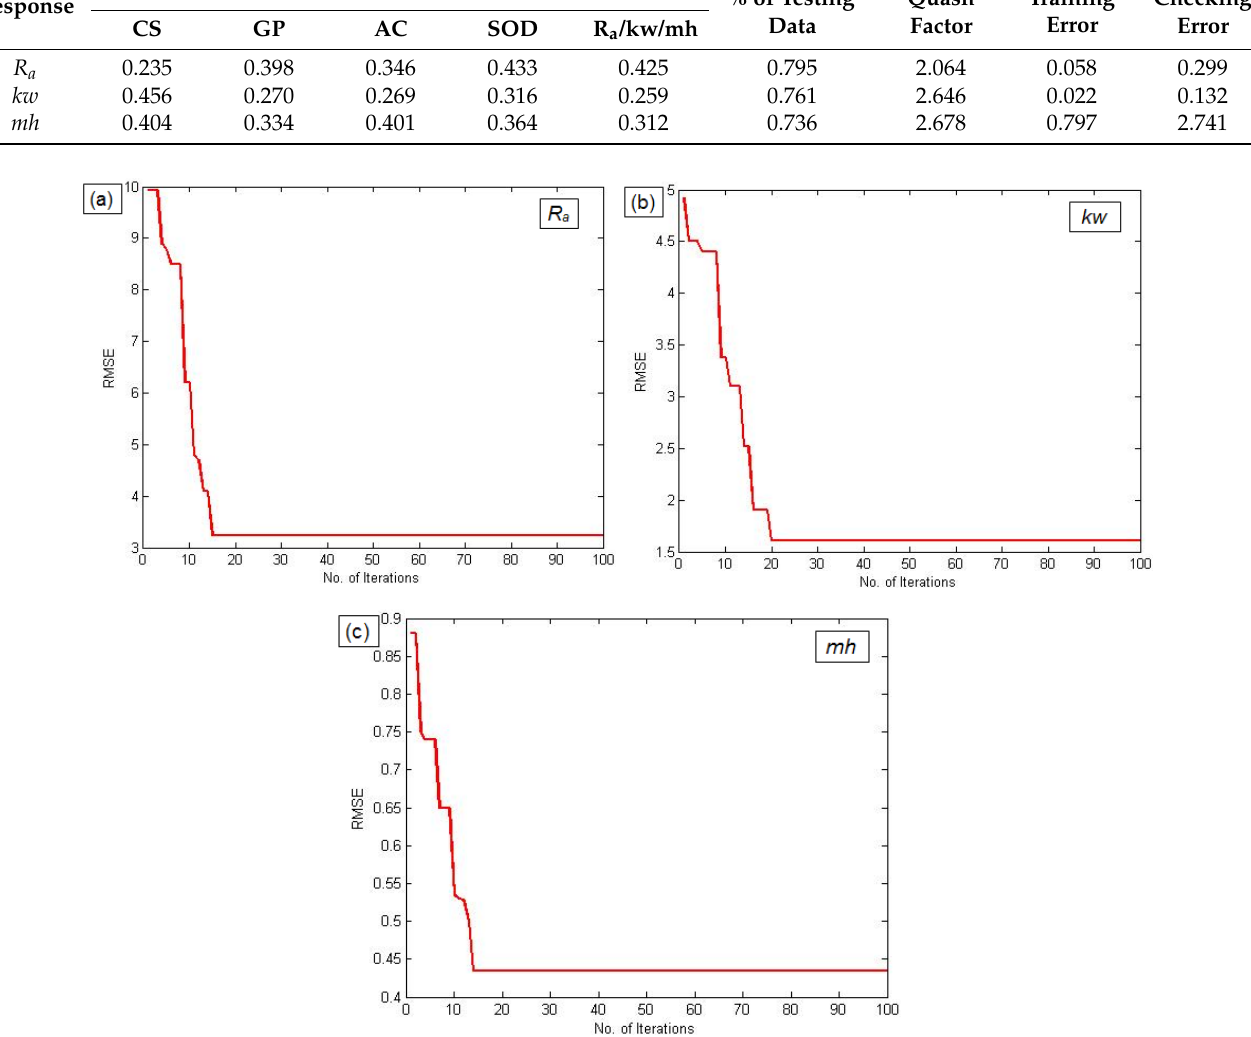
Figure 6. GA convergence plots for ANFIS parameter tuning: ( a ) Ra , ( b ) kw, and ( c ) mh . From the results of GA trained ANFIS, the optimal parameters of the FIS network were obtained. As per the available twenty-nine items of experimental data, twenty da- tasets were considered as the optimal values for the training of the ANFIS network. The remaining nine data items were considered for validating the performance of the trained network. Figure 7a – c shows the scatter plots of the training and checking errors obtained from ANFIS. The errors of the training and testing data of actual and forecast values for Ra , kw , and mh are listed in Table 5. From these results, it is observed that the proposed GA trained ANFIS model provides a close correlation between the PAC parameters and their responses, with minimal training and testing errors, which demonstrates the relia- bility of the proposed approach.